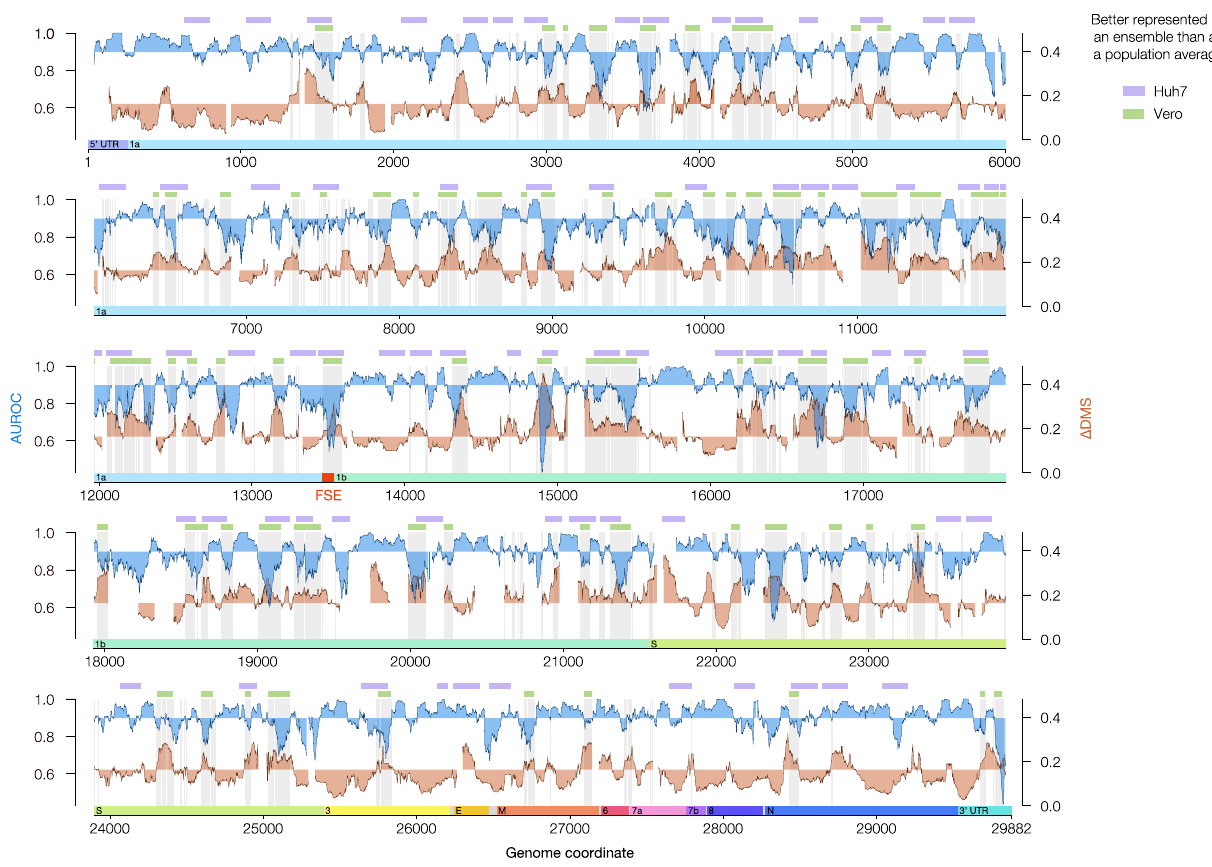
Fig. 3 Alternative RNA structures form across the SARS-CoV-2 genome. Agreement between DMS reactivities and predicted secondary structures (AUROC, blue) and the difference in DMS reactivity between clusters 1 and 2 ( Δ DMS, orange) for the genome-wide model in Vero. Both quantities were calculated over sliding windows of 80 nt in 1 nt increments; x values represent the centers of the windows. Windows with <10 paired or <10 unpaired bases were excluded from the calculation of AUROC; windows with <10 bases that clustered into at least two structures were excluded from the calculation of Δ DMS. For AUROC and Δ DMS, the area between the local value and the genome-wide median is shaded. For the Vero model, all coordinates best described by structure ensembles (AUROC below median, Δ DMS above median) are shaded in light gray. The green bars represent a denoised version of these coordinates (see Methods). For the Huh7 model, regions meeting criteria for alternative structures (see Methods) are labeled with lavender bars. The locations of the untranslated regions (UTRs) and open reading frames (ORFs) of SARS-CoV-2 are indicated below the AUROC and Δ DMS data. The frameshifting stimulation element (FSE, coordinates 13,462 – 13,546) is highlighted in red. Source data are provided as a Source Data fi